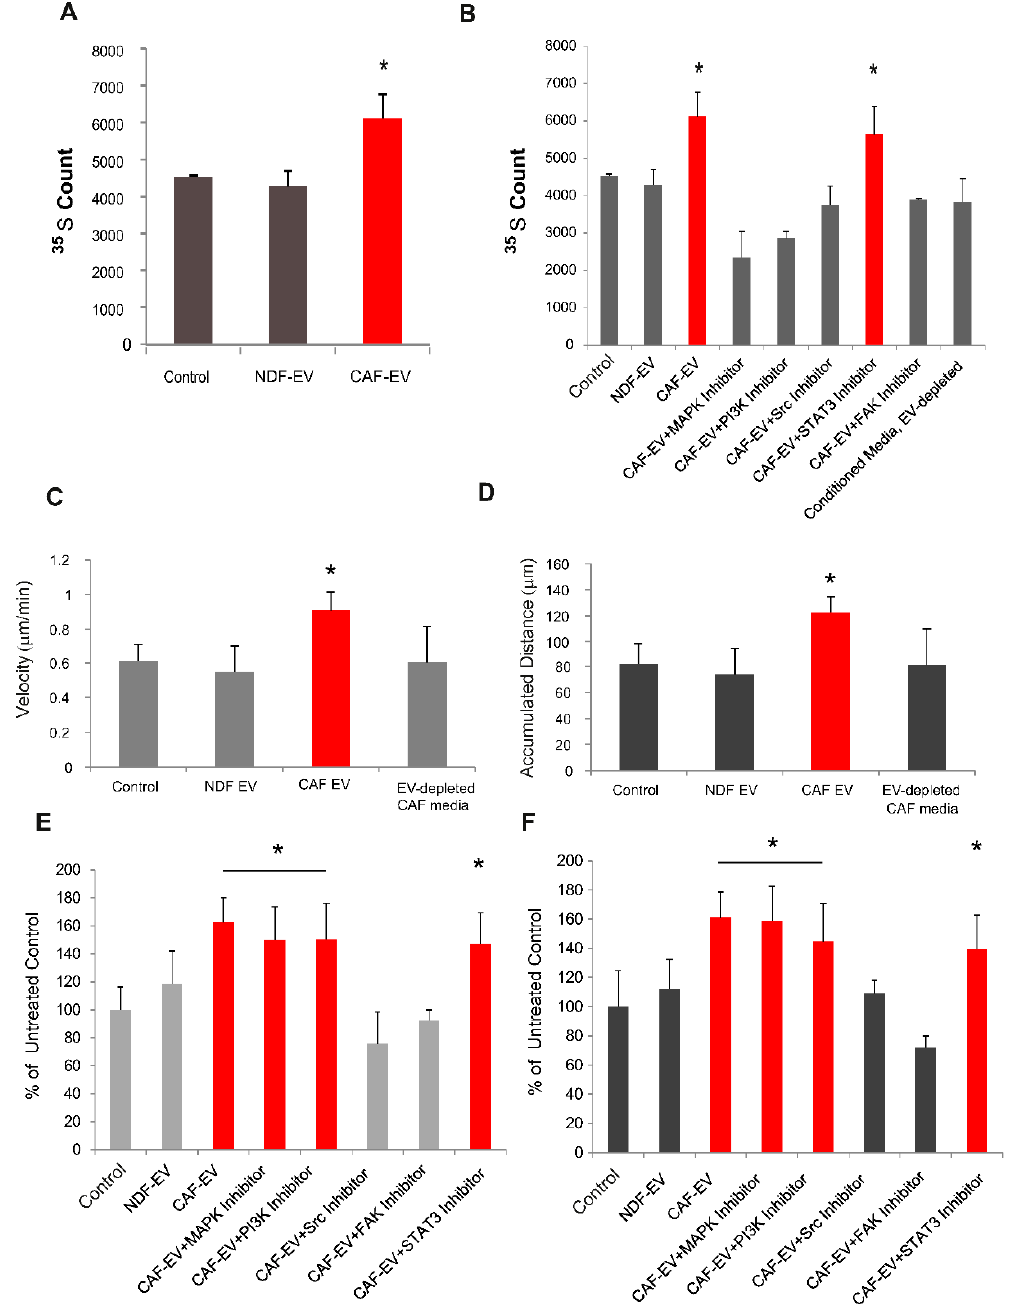
Figure 4. CAF-derived EVs increase translational activity and motility of mesothelial cells. ( A ) Met 35S incorporation in LP-9 cells treated with CAF- or NDHF-derived EVs for 24 h compared to untreated LP-9 cells (Control). ( B ) The translational activity of LP-9 cells treated with CAF-EVs in the presence or absence of inhibitors of MAPK, PI3K, Src, STAT3 and FAK. Induction of mRNA translation by CAF-EVs is MAPK- and PI3K-dependent. Velocity ( C ) and accumulated distance ( D ) of LP-9 cells treated with CAF- or NDHF-derived EVs for 24 h, compared to treatment with EV-depleted CAF-conditioned media or untreated control. Velocity ( E ) and accumulated distance ( F ) of LP-9 cells treated with CAF-EVs in the presence or absence of kinases inhibitors for 24 h expressed as a percentage of untreated control cells. In all panels, error bars show mean ± SD from three independent experiments with statistical significance estimated using the two-tailed Student’s t -test, * p <